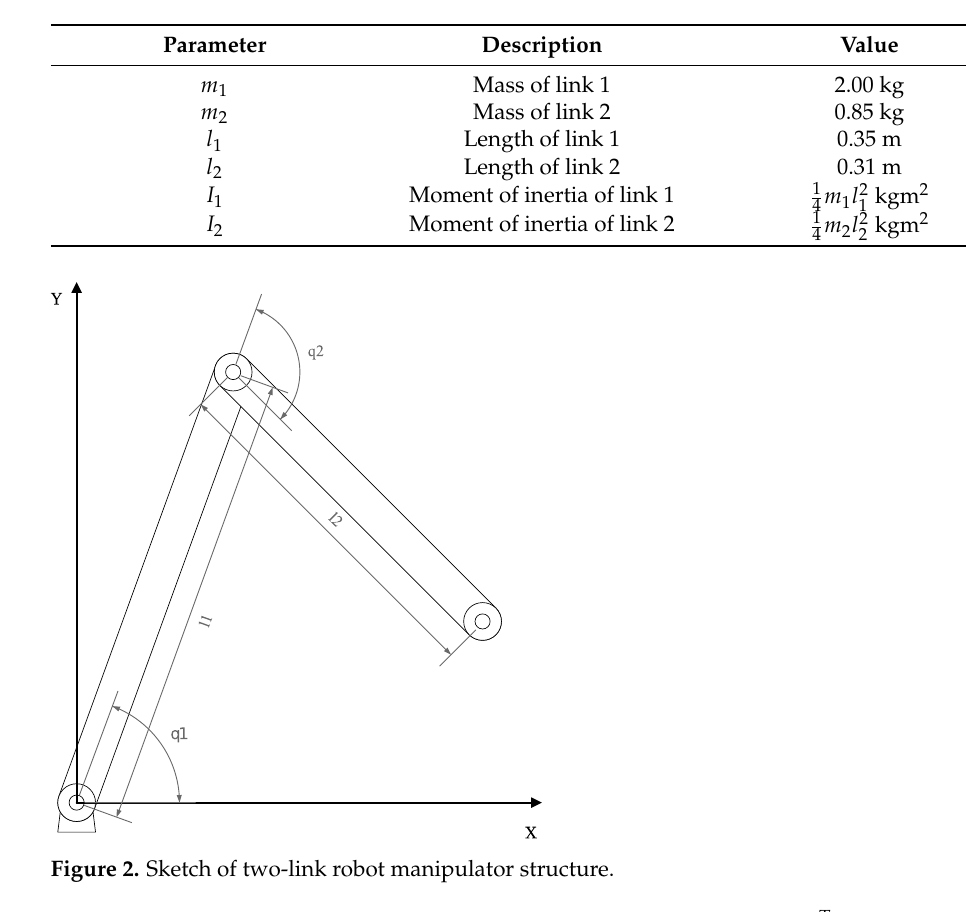
Table 1. Parameters of the robot.